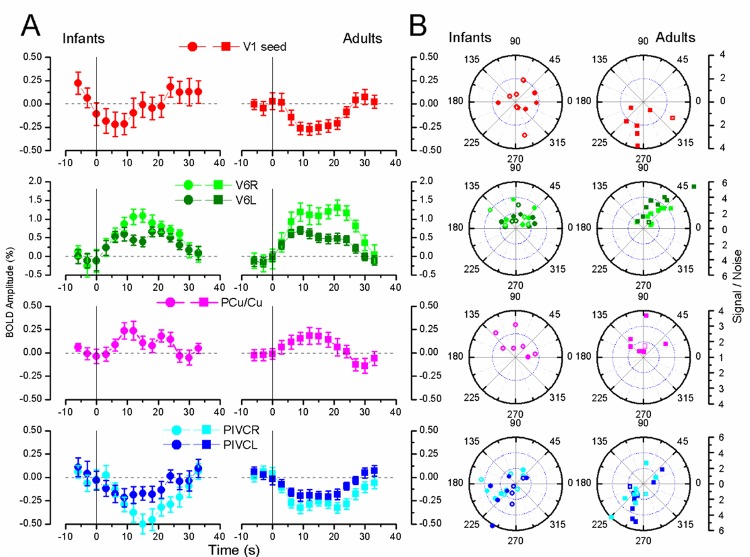
Average time-course and individual Signal to Noise ratio of the motion BOLD response.A: Average time-course for V1 seed, V6, PCu/Cu, PIVC/PIC in infants (left) and adults (right) in response to coherent versus random flow-motion (threshold at p ≤ 0.05). Light colours refer to the right hemispheres ROIs, darker colours to the left. Bars represent ±1 sem. Infant and adult responses are very similar. B: Signal to Noise ratio polar plot for individual subjects (left column infants, right column adults). Convention as in Fig 1C and 1D. The points form clear clusters indicating that the response is reliable. For only the V1 seed did two infants have S/N less than 1. Note that the scale in A for V6 ROI is compressed, given the larger activity of this area. Filled symbols correspond to p < 0.01, open to 0.01 < p < 0.05 threshold. (V1: primary visual cortex; MT+: temporo-occipital complex; V6: Visual area six on medial-parieto-occipital region; PIVC: posterior insular vestibular cortex; PCu/Cu: Pre-Cuneus/Cuneus.) Numerical data are available in S1 Data, Fig 3.